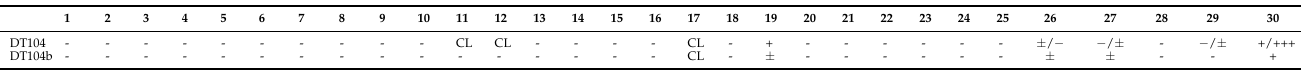
Table 1. Phage reaction pattern of the panel of 30 typing phages in Salmonella Typhimurium DT104 and DT104b. Variable degrees of reaction: − , no reaction; ± , weak reaction (1–20 plaques); +, 21–40 plaques; +++, 81–100 plaques; CL, confluent clear lysis; ± / − , variable